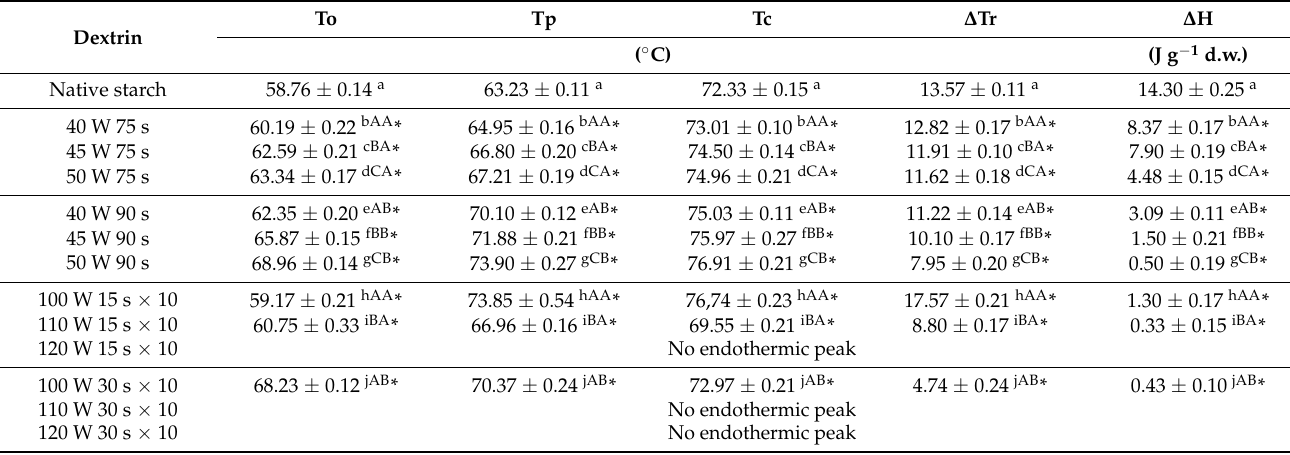
Table 3. Gelatinization parameters of dextrins prepared under continuous and discontinuous microwave-assisted heating and native of potato starch. To Dextrin